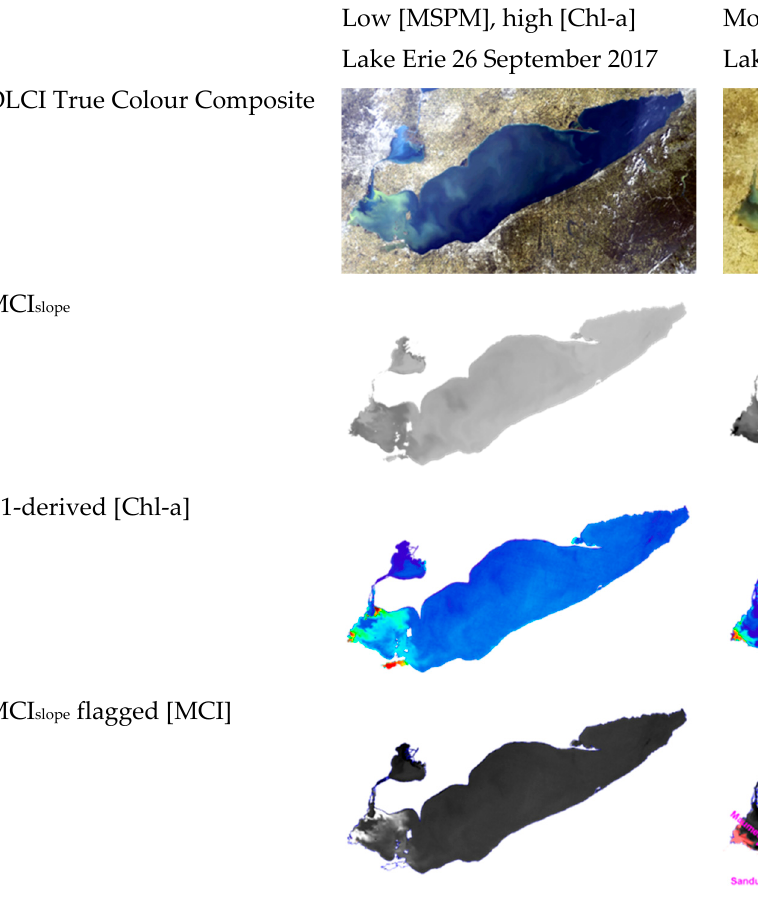
Figure 8. Three examples of the ocean and land colour instrument (OLCI) scenes showing an RGB true colour composite, MCIslope, L1 MCI-derived [Chl-a], MCIslope mask area overlaid on MCI, using MCI > 0 mW / (m 2 · sr · nm) and MCIslope < − 0.15 nm − 1 . 3